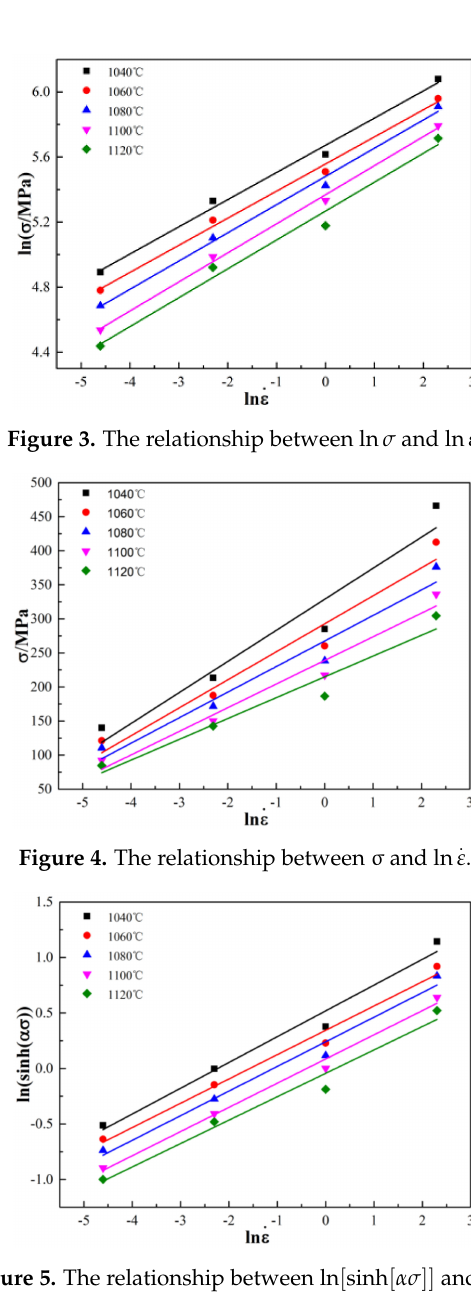
Figure 5. The relationship between ln [ sinh [ ασ ]] and ln